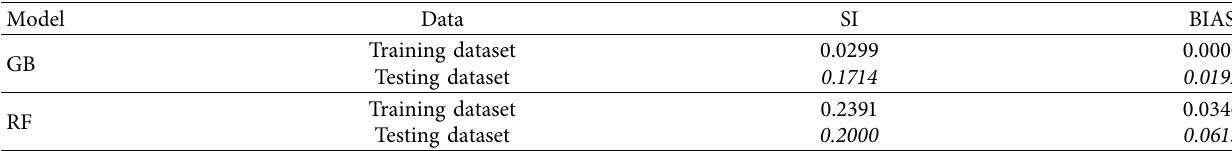
Figure 5: Comparison between the experimental and the predicted permeability coefficient of soil in two cases: (a) RF model and (b) GB model. Table 5: SI and BIAS values of the GB and RF models.